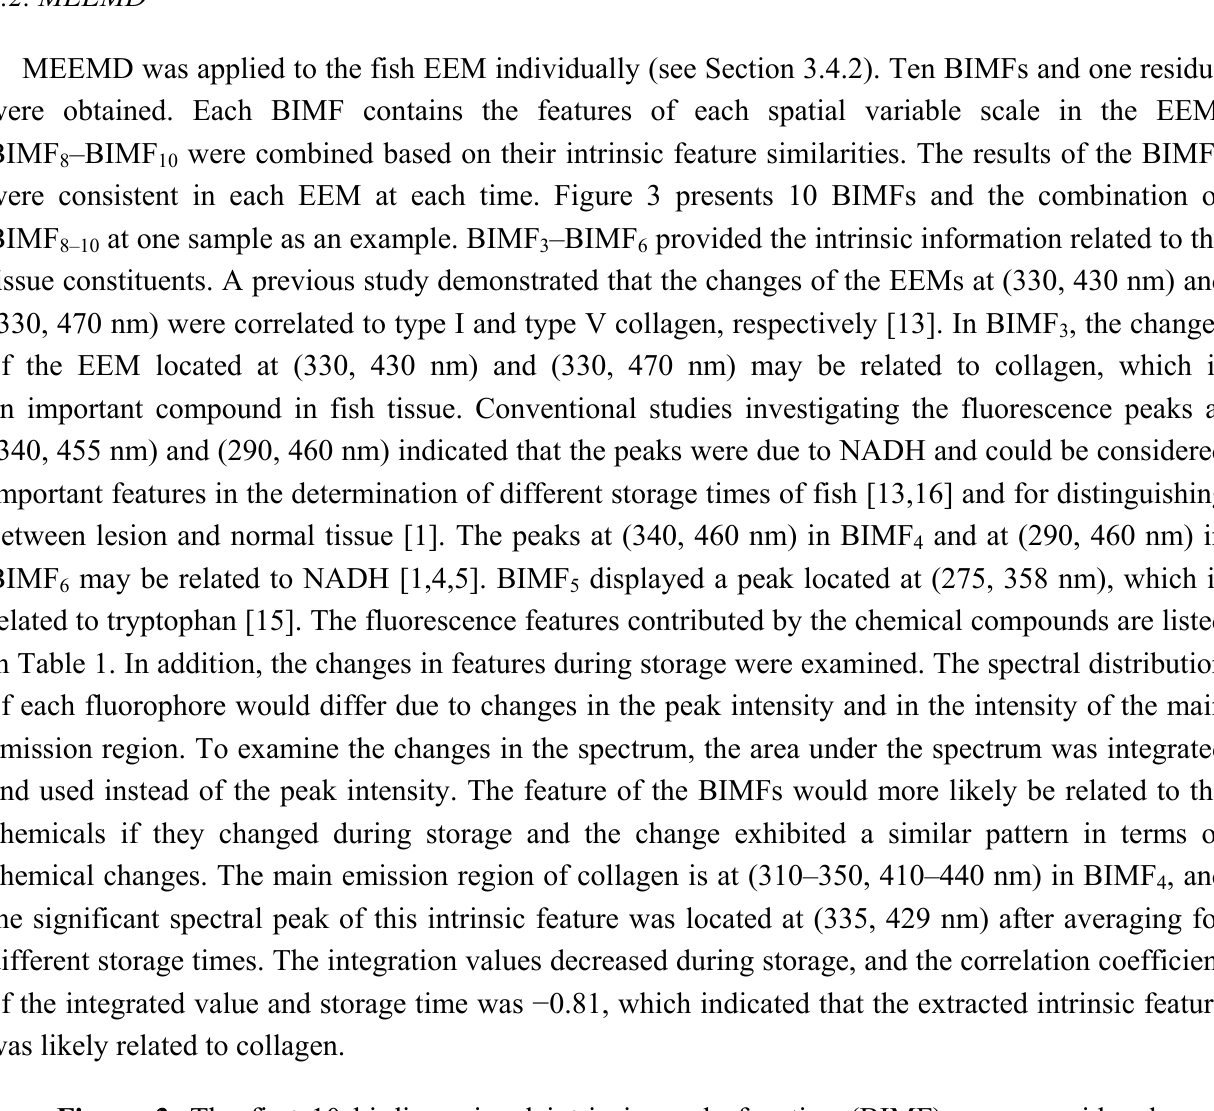
Figure 3. The first 10 bi-dimensional intrinsic mode function (BIMF) were considered –BIMF , which are in the dashed box, were combined important after modeling. BIMF 8 10 as BIMF 8–10